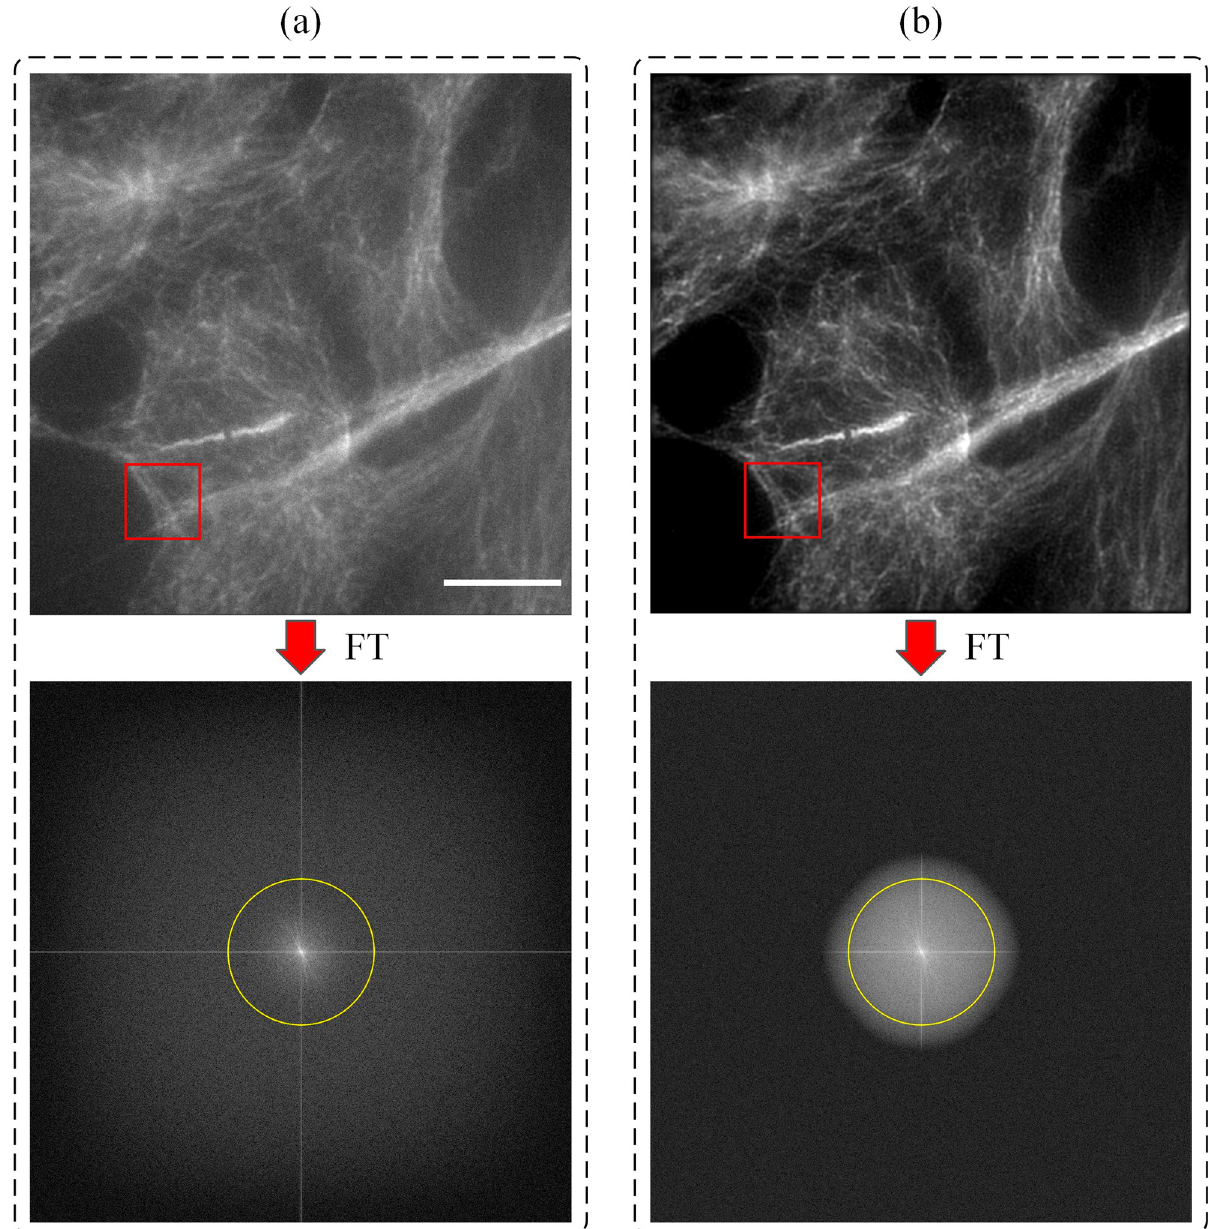
Fig 9. Cos7 cells were labelled for tubulin (Alexa Fluor 488). Microtubule images obtained with (a) wide-field illumination and (b) SIM reconstruction are shown together with their Fourier transforms. Scale bar indicates 10 μ m. Yellow circles indicates the limits of assumed